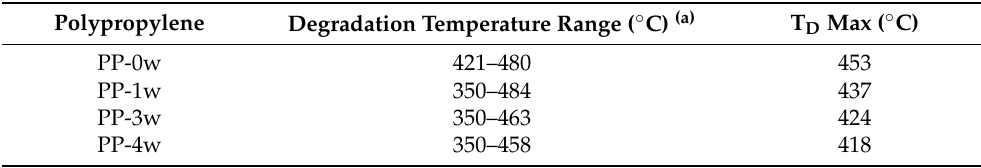
Table 1. Degradation temperature ranges and peak maxima (T D max) obtained from the evolved gas analysis–mass spectrometry (EGA–MS) profiles of the PP